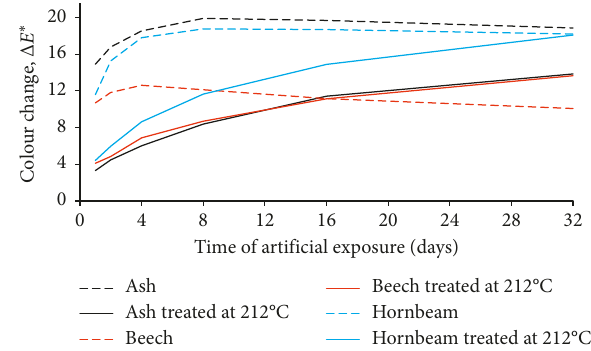
Figure 2: Colour change of untreated and heat-treated ash, beech, and hornbeam wood samples at 212 ° C